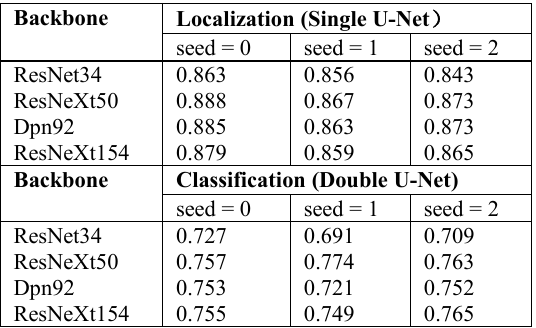
Table 3 . F1 score of U-Net model under four backbone models